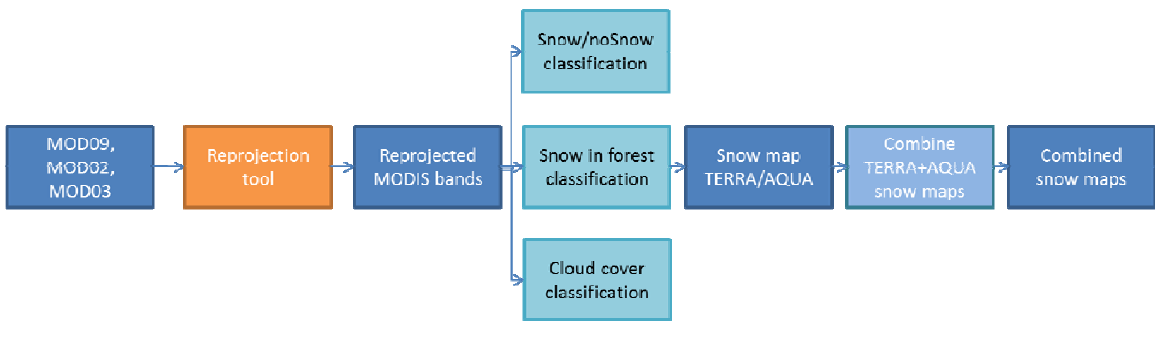
Figure 3. Overview of the processing steps of the three main modules dedicated respectively to snow, snow in forest and cloud